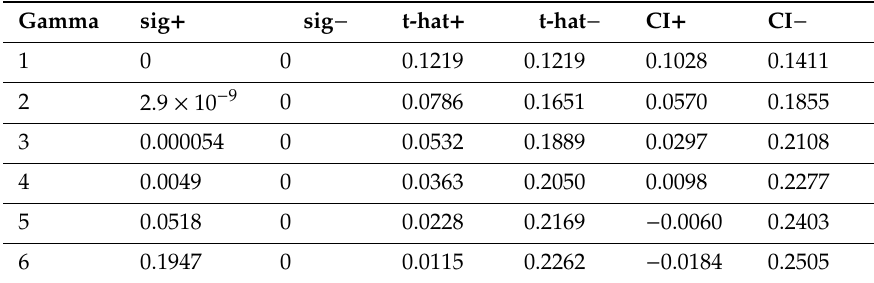
Table 10. Result of the Rosenbaum sensitivity analysis.